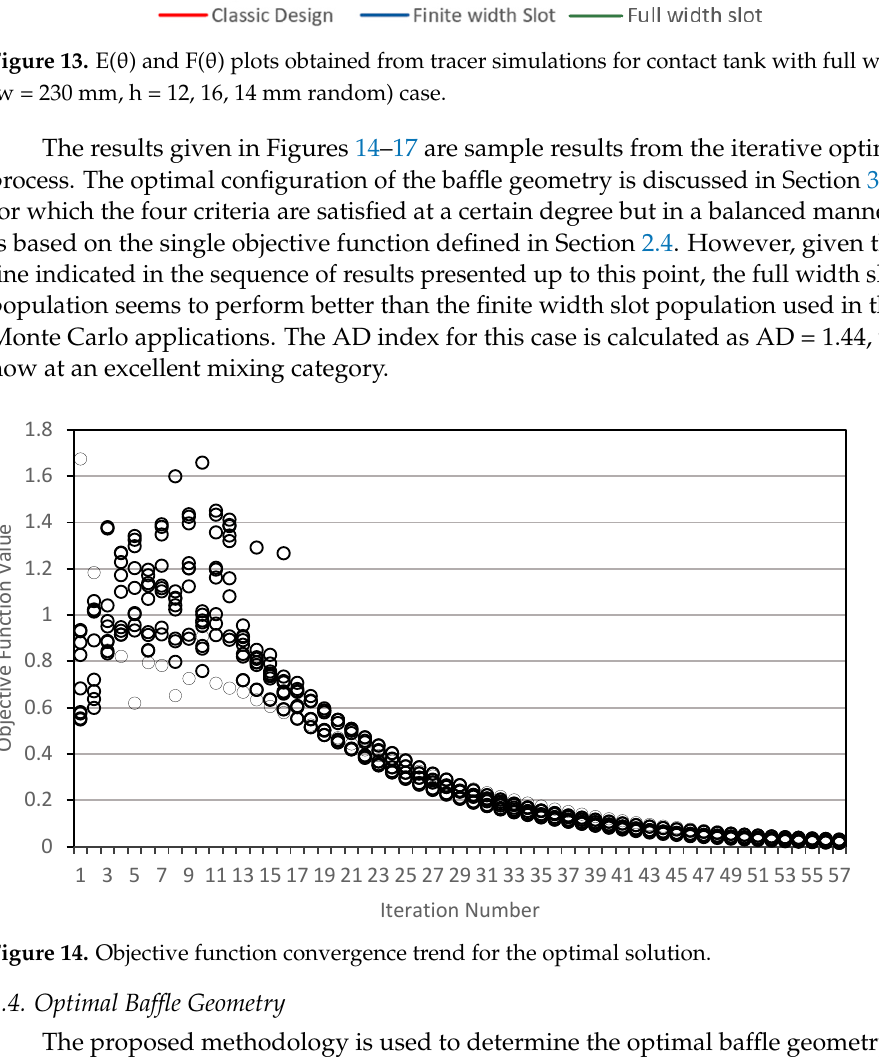
Figure 14. Objective function convergence trend for the optimal solution.